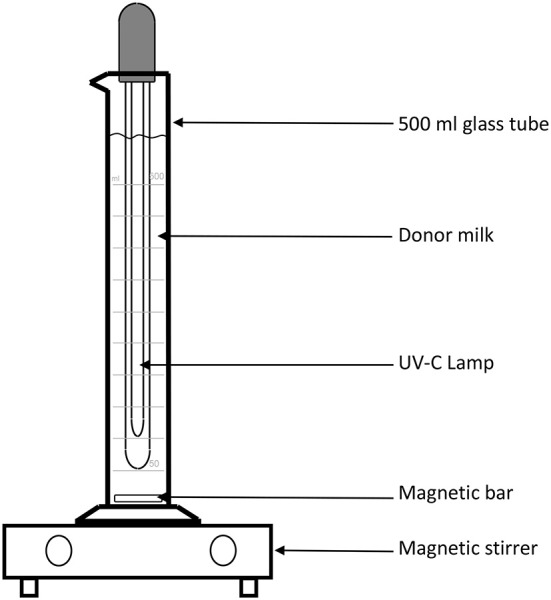
Schematic representation of the device used to treat donor human milk with UV-irradiation.